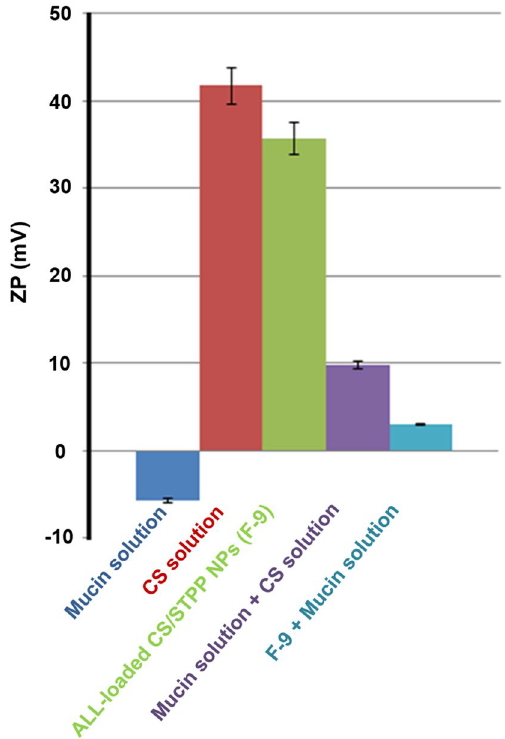
Figure 8. ζ-potential of mucin solution (0.5 mg/mL), CS solution (1.5% (w/v)), mucin solution + CS solution and ALL-loaded CS/STPP NPs (F-9) before and after incubation with mucin at 37 °C for 1 h. Results represents the mean ± SD (n = 3) and the graph was plotted using Microsoft Excel (2010), version 14.0.4734.1000, (www. Microsoft Office 2010.com).